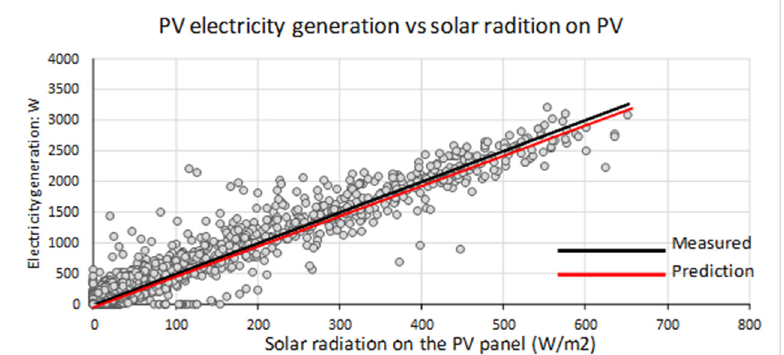
Figure 8. Electricity generation by PV vs. Solar on the PV panel (October 2015 to March 2016), comparing measured (grey markers and black trend line) and predicted (red line) data.